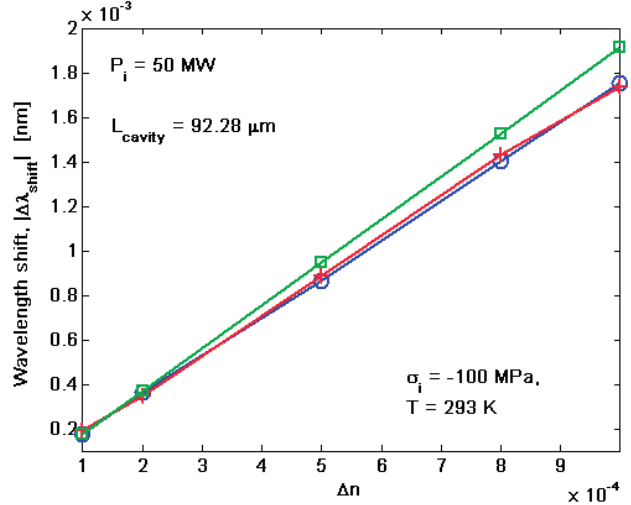
Figure 9. Resonance wavelength shift versus the cover refractive index